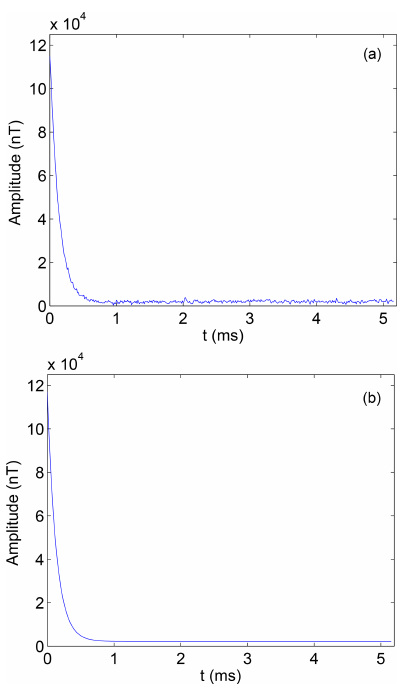
Figure 2. (a) Actual signal curves. (b) Inversion of theoretical sig- nal